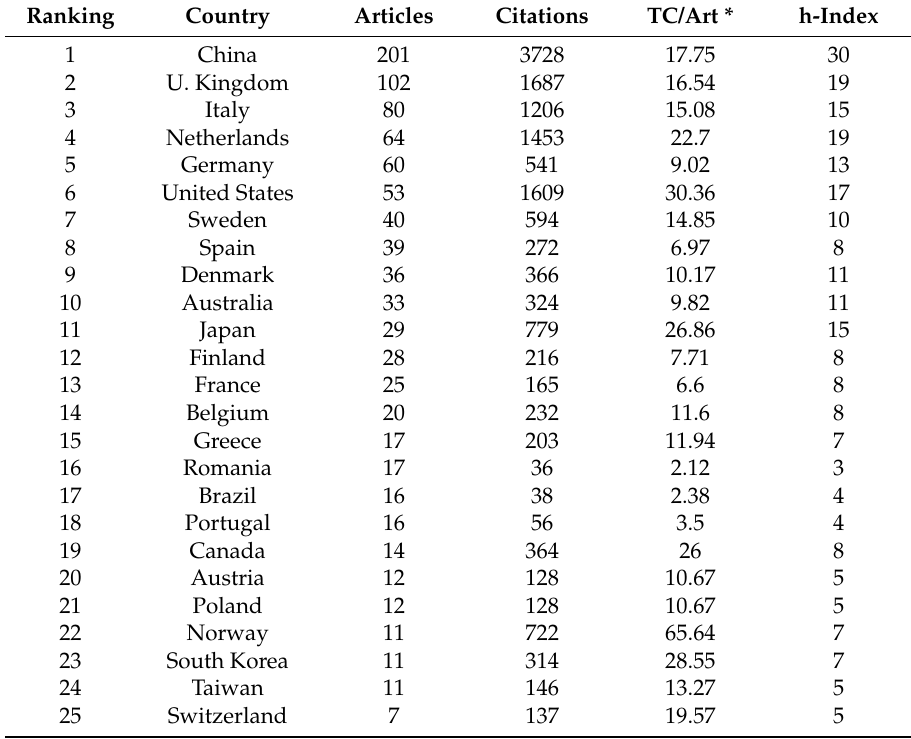
Table 1. Ranking of countries attending the highest number of articles and